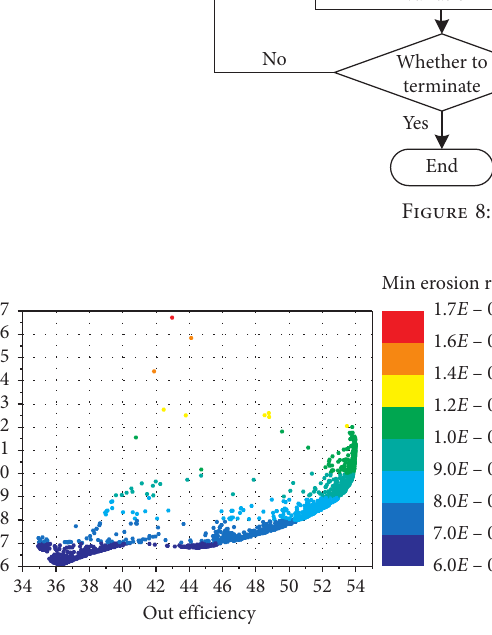
Figure 9: Front of Pareto. Table 5: Comparison of geometric parameters before and after optimization. Figure 10: Comparison of performance of the vortex pump before and after